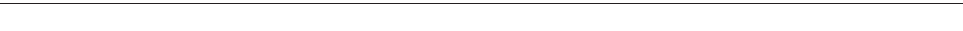
Fig. 3 Blimp1-derived cells represent highly clonogenic and long-lived Elf5 + ER α − PR − luminal progenitors. a Lineage tracing strategy adopted in b – f . Nine- week-old adult virgin Prdm1Cre ERT2/ + ; R26R mTmG/ + females were injected with TAM (4 mg/25 g body weight) and analysed 24 h or 8w later (24 h or 8w p. i.). b FACS analysis of 9-week-old adult virgin mammary gland MECs at 24 h post-TAM induction. CD45 + leukocytes and CD31 + endothelial cells were removed and total epithelial cells gated on a CD24/CD49f plot. Left: FACS plot showing discrimination of basal (CD24 low CD49f high ) and luminal (CD24 high CD49f low ) cell populations. Right: FACS plot showing distribution of GFP + cells within stromal, luminal and basal cell populations ( n = 6 mice pooled from two independent experiments). c Percentages of GFP + stromal (0.39% GFP + cells), luminal (0.22% GFP + cells) and basal (0.008% GFP